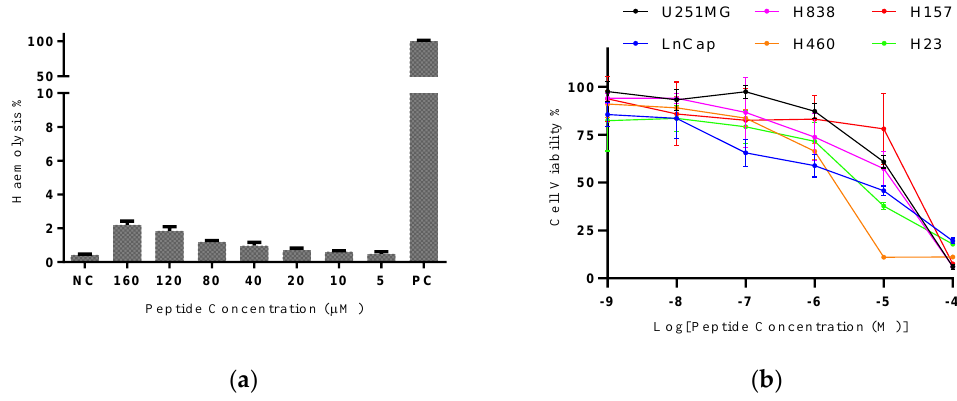
Figure 5. ( a ) Hemolytic activity of kassinatuerin-3 on the horse erythrocytes. PBS and 0.1% TritonX-100 were used as the negative control (N) and positive control (P), respectively. ( b ) Anti-proliferative effects of kassinatuerin-3 on a range of cancer cells within a concentration range of 10 −4 to 10 −9 M. Paclitaxel (1 μM) was used as the positive control. The 100% cell viability was measured in the cells with serum-free medium only. Data represent means ± SD of five replicates.